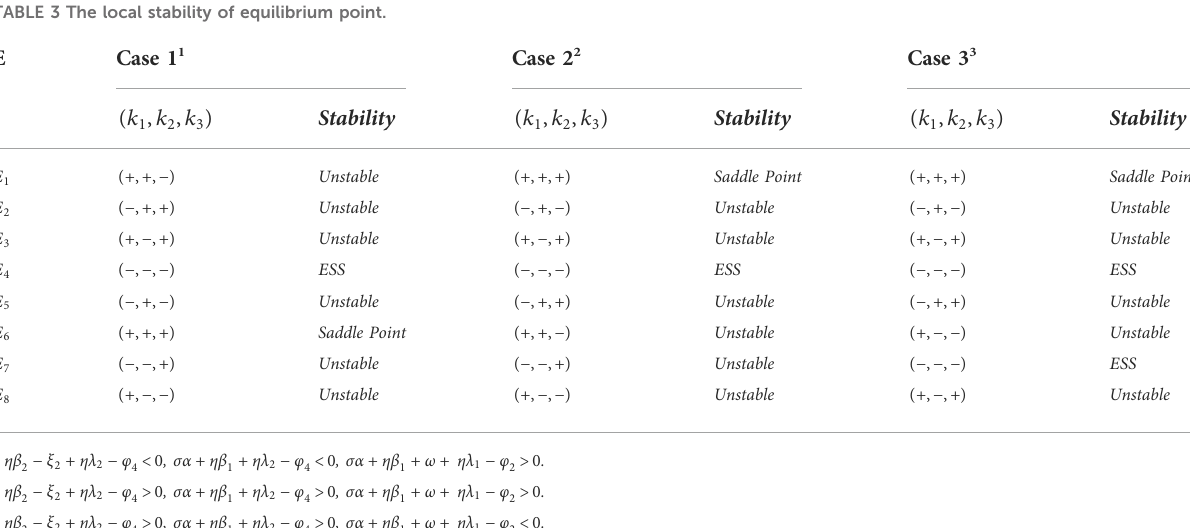
TABLE 3 The local stability of equilibrium